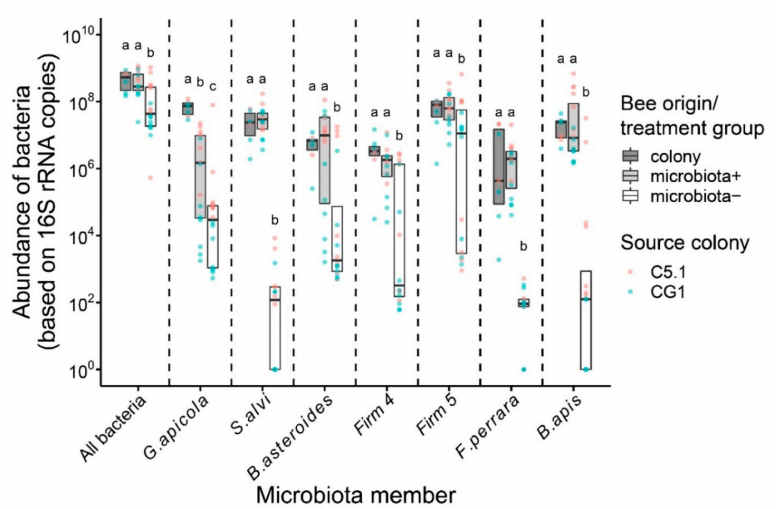
Figure 1. Abundance of six honey bee gut microbiota members ( G. apicola , F. perrara , S. alvi , B. apis , B. asteroids , Lactobacillus group Firm-4, and Firm-5 ) and universally all bacteria (16S) in experimen- tal bees at day six. Experimental bees were either fed bee gut microbiota (microbiota+) or not (microbiota − ) at adult emergence to establish the normal gut microbiota. Bees directly out of source colonies (colony) served as a comparison. Lower case letters indicate statistically significant differences at α = 0.05 within groups separated by dashed lines. Boxplots show the median and interquartile range. Points represent individual bees, and colors indicate bee source colony of